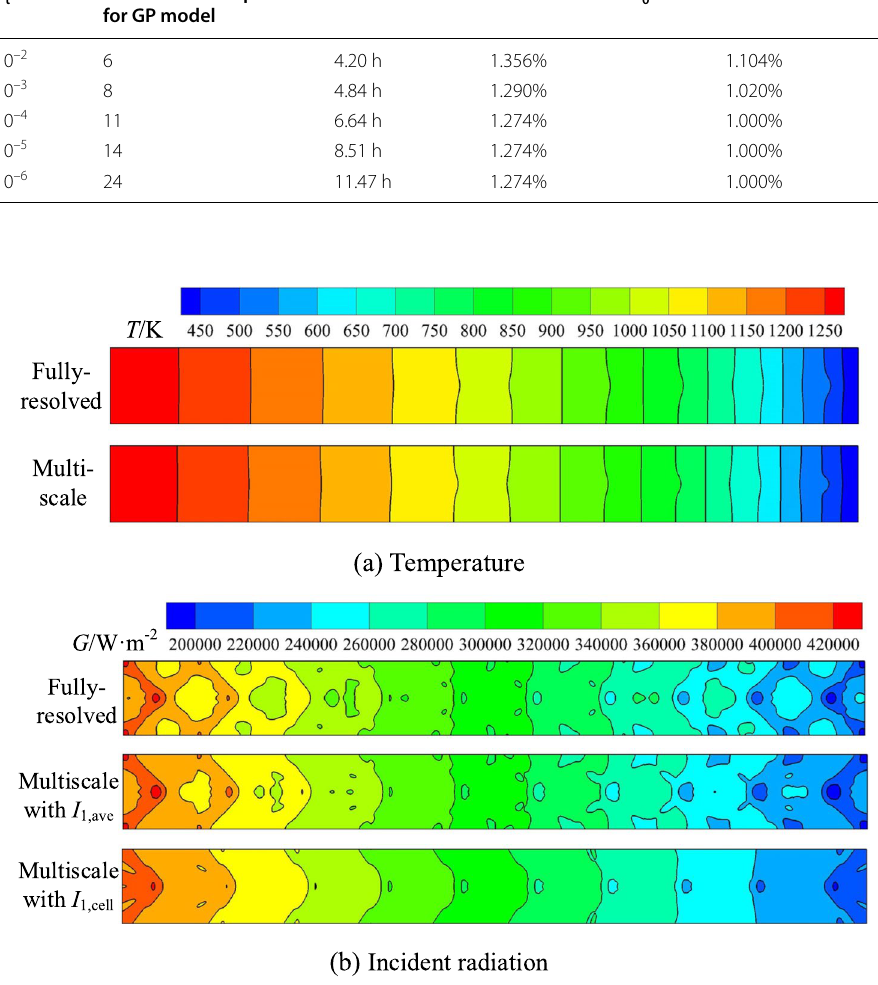
Table 2 Results for the multiscale simulations with different threshold σ σ t